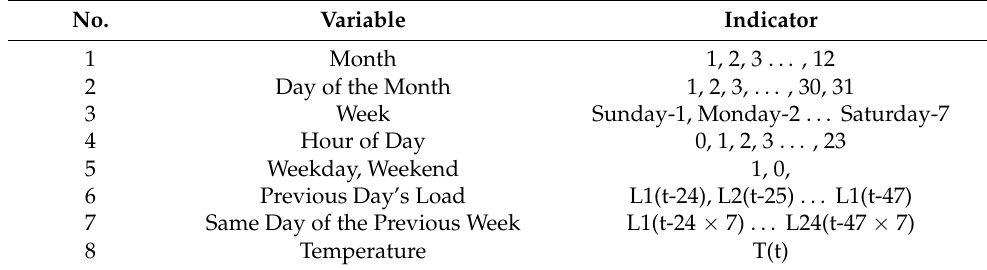
Table 3. ANN input variables.